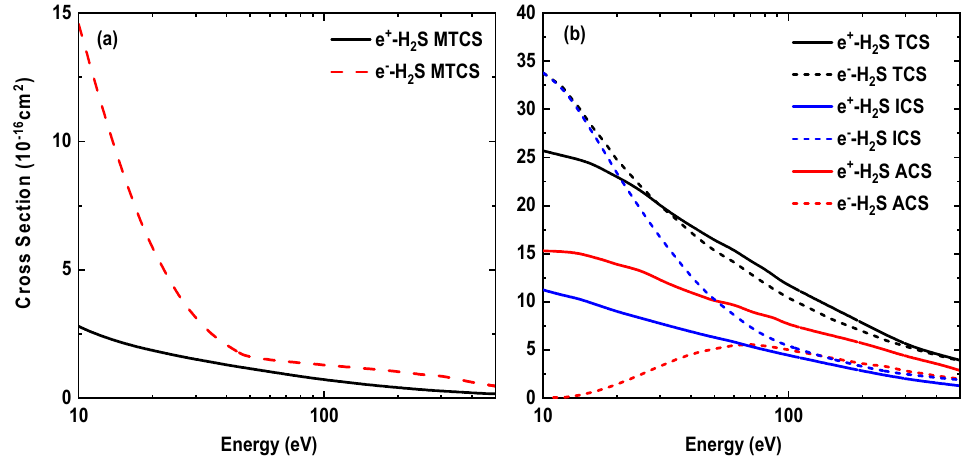
Figure 9. Comparison of cross sections for positron and electron scattering from H 2 S as a function of incident projectile energy. The left graph ( a ) shows MTCSs, while the right graph ( b ) presents ICSs, ACSs and TCSs.